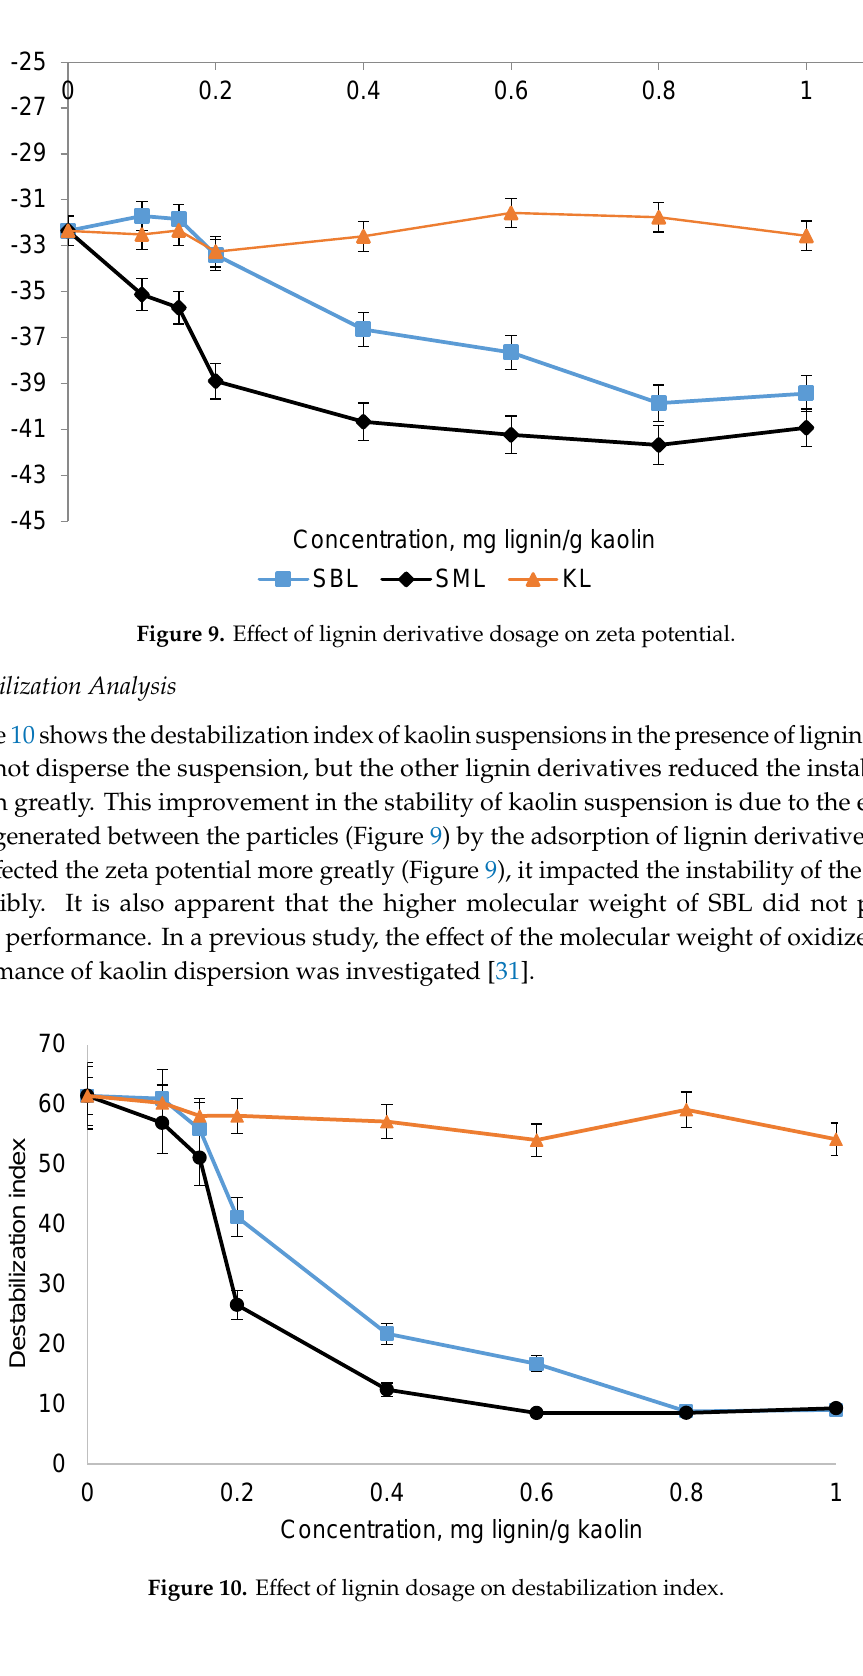
Figure 10. Effect of lignin dosage on destabilization index.